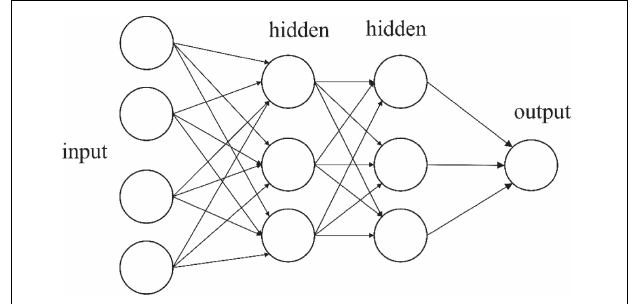
FIGURE 1 | The construction of deep neural